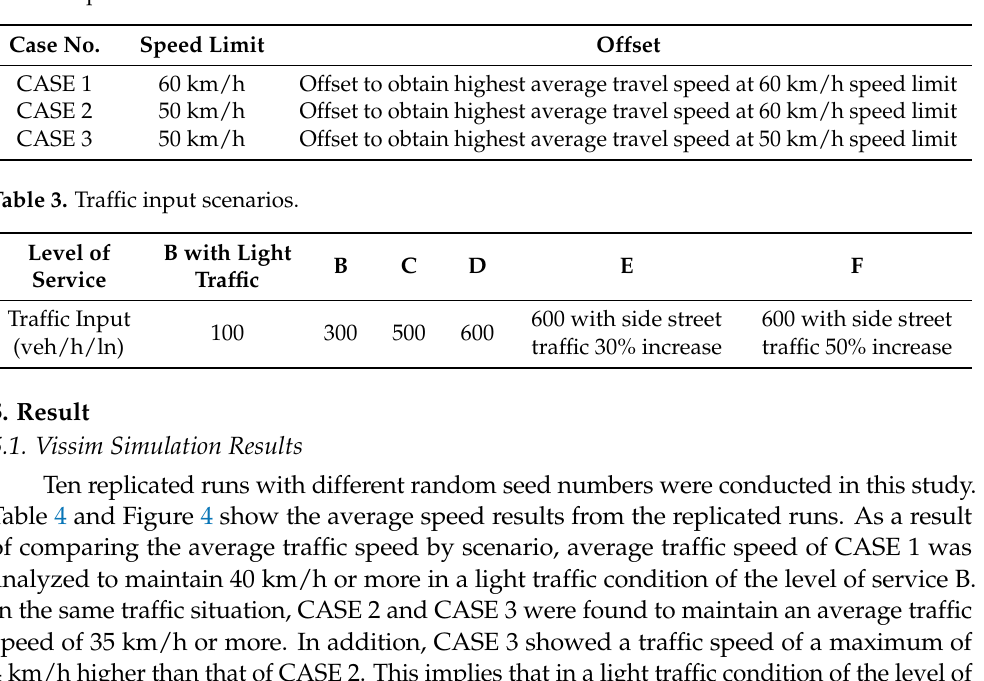
Table 2. Speed limit and offset scenarios.